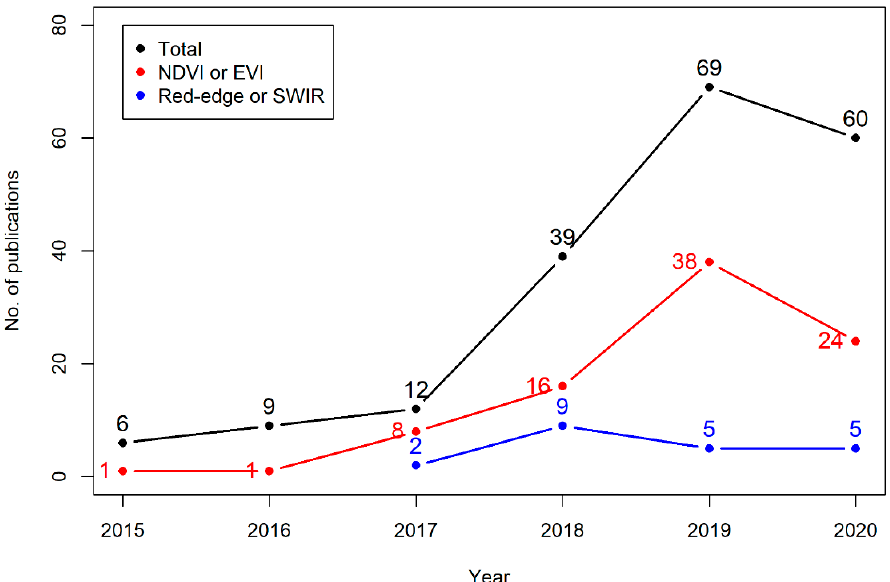
Figure 1. Frequency of publications (obtained from the Scopus database) mentioning “Phenology” and “Sentinel-2” in their abstract, title or keywords are shown as “Total” in black. The subset of the “Total” publications that includes “normalised difference vegetation index (NDVI) or enhanced vegetation index (EVI)” and “Red-edge or short wave infra-red (SWIR)” are shown in red and blue, respectively. The year 2020 includes papers published up to the month of August 2020.